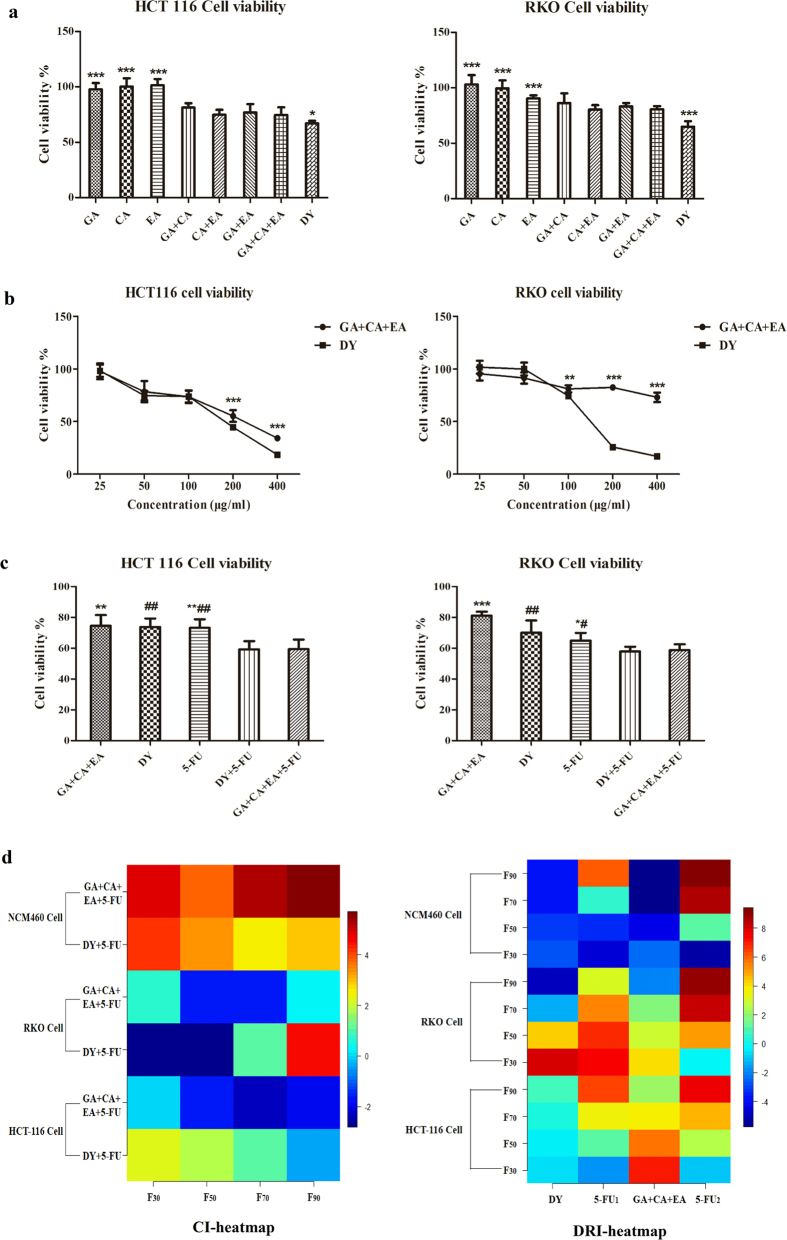
Three tannins in DY dramatically sensitized CRC cells to the 5-FU therapy.(a) Cells were treated with GA, CA or EA separately or in a combination, cell viabilities were evaluate by CCK8 assay. *P < 0.05, **P < 0.01, ***P < 0.001, compared with (GA + CA + EA) groups. (b) Concentration-effect curves of three tannins and DY were plotted, *P < 0.05, **P < 0.01, ***P < 0.001, vs DY groups. (c) The synergistic anti-proliferative effects of the three tannins and DY on the cytotoxicity of 5-FU in CRC cells. #P < 0.05, ##P < 0.01, ###P < 0.001, vs (DY + 5-FU) group. While *P < 0.05, **P < 0.01, ***P < 0.001, vs (GA + CA + EA + 5-FU) group. All the data are expressed as mean ± SD (n = 3). (d) CI and DRI values from different combined groups are demonstrated in the heat-maps plotted by R programming, which are assessed by the color bars on the right (→red, values are greater; →blue, values are lower; 5-FU1 and 5-FU2 represent DRIs in the DY + 5-FU and tanins+5-FU groups, respectively; F30–F90, 30% to 90% effective rate).